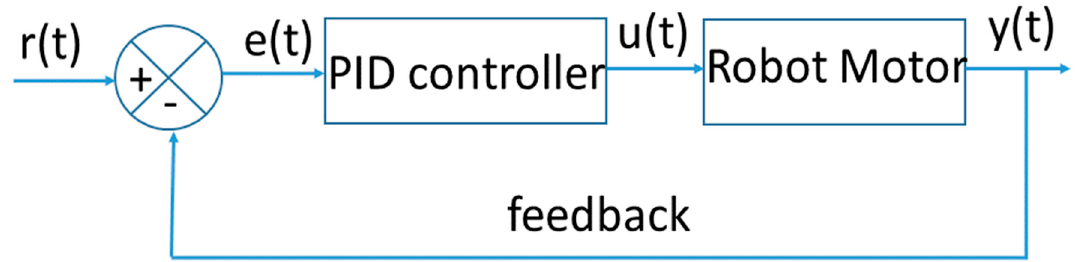
Figure 6. Diagram of the proportional integral derivative (PID) controller.